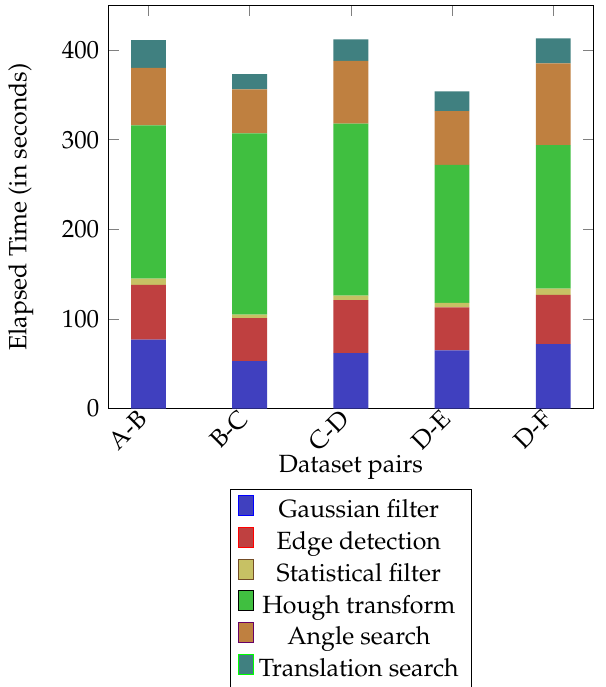
Figure 4. Runtime analysis.